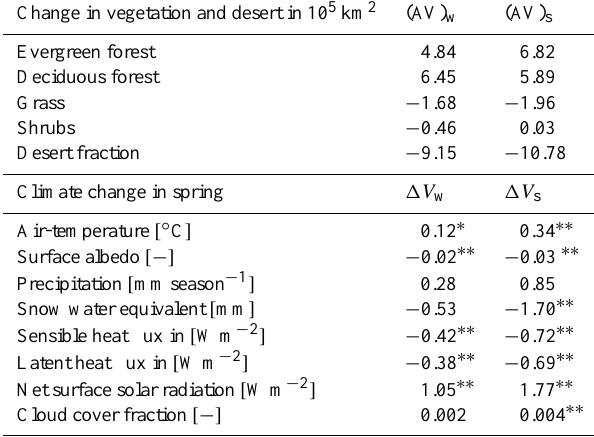
Table 3. Change in vegetation and desert fraction of the atmosphere-vegetation simulations (AV) w and (AV) s . Below the climate parameters of the pure atmosphere-vegetation interaction of the simulations with both weak snow masking, 1V w , and strong snow masking, 1V s . The change in vegetation cover is derived from the simulations with dynamic vegetation. All values are spring mean values and averaged over land over the area 60 ◦ –90 ◦ N. Please note that fluxes towards the atmosphere (sensible and latent heat fluxes) are